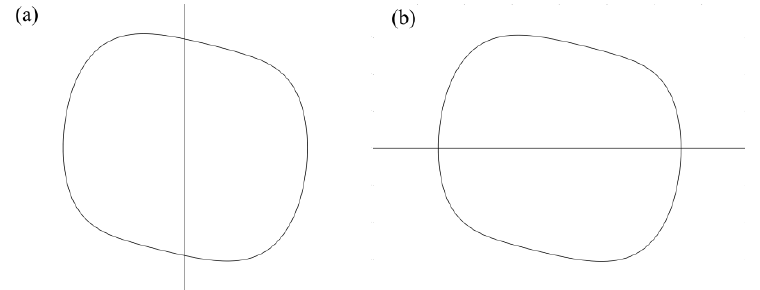
Figure 7. Segmentation of phase diagram; ( a ) dividing the phase diagram with a vertical line of x = 0, ( b ) dividing phase diagram with a horizontal line of y = 0.